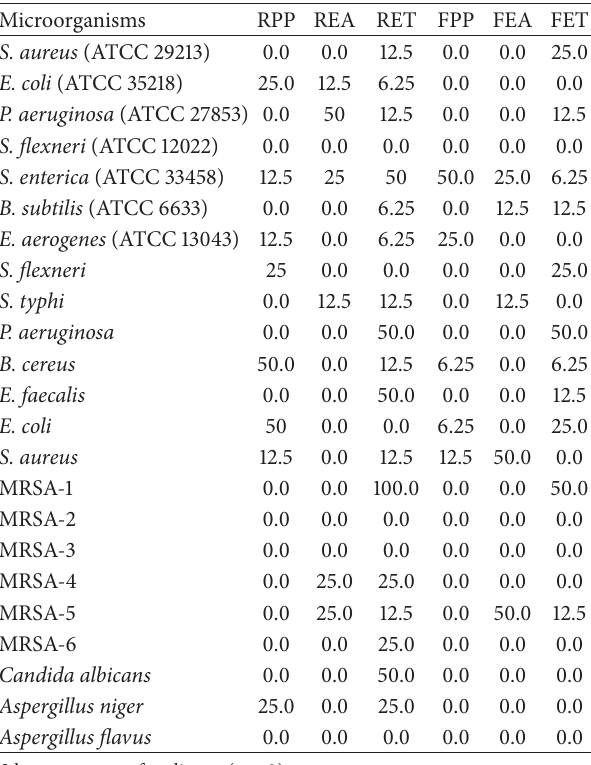
Table 5: Minimum inhibitory concentration (MIC) of Lenzites quercina extracts (mg/mL) against tested organisms.